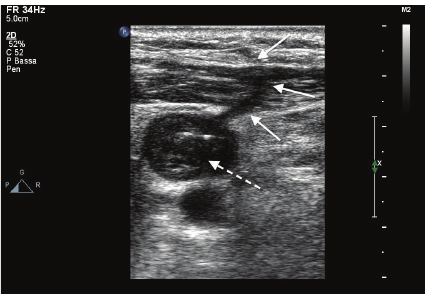
Figure 4: Vascular ultrasonography showing total thrombotic occlusion of the left internal jugular vein (dotted arrow) and fibrin sheath between the vein and the dermis (white